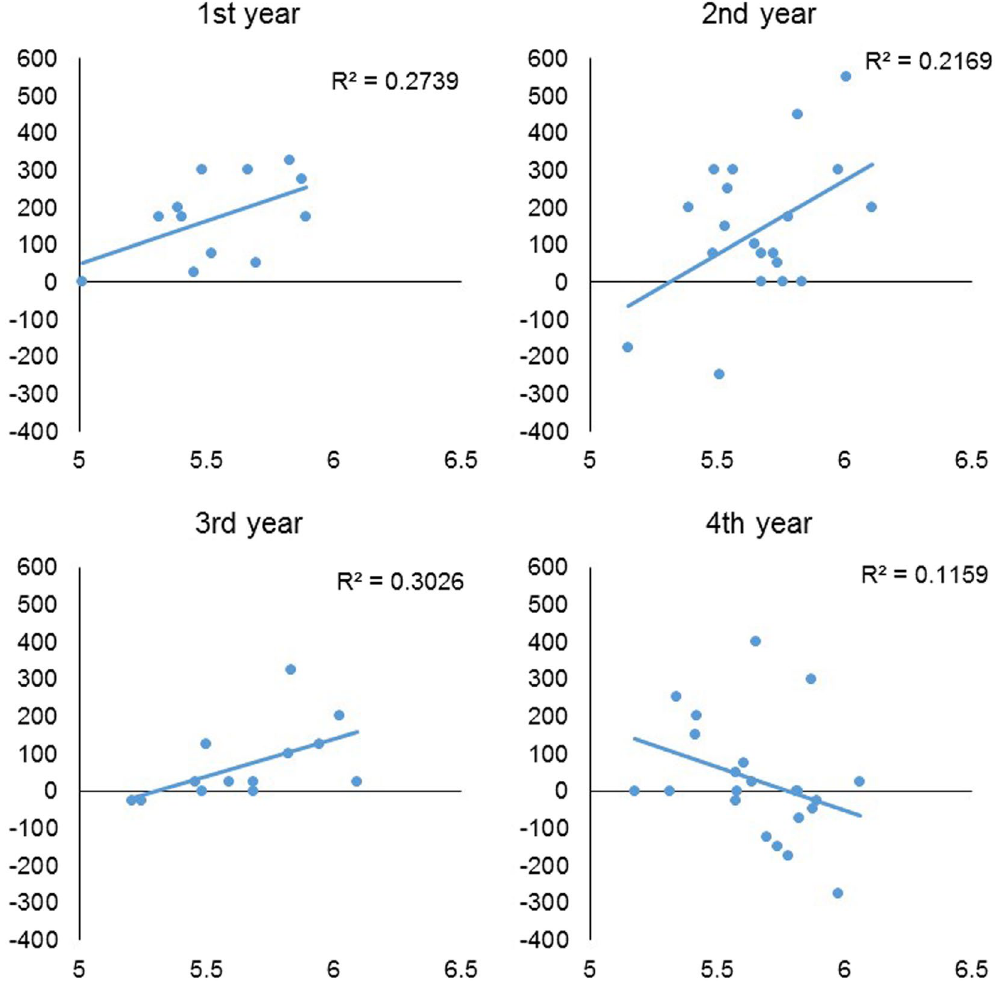
Figure 4. Plot of the Pre-T (pmol/L) levels (X-axis) and overall levels of acquiescence (Y-axis) in each year. R-squares were calculated from univariate linear regression analysis. Spearman’s correlation coefficient: first years ( r s = 0.40, p = 0.20), second years ( r s = 0.28, p = 0.24), third years ( r s = 0.68, p = 0.01), fourth years ( r s = − 0.40, p =